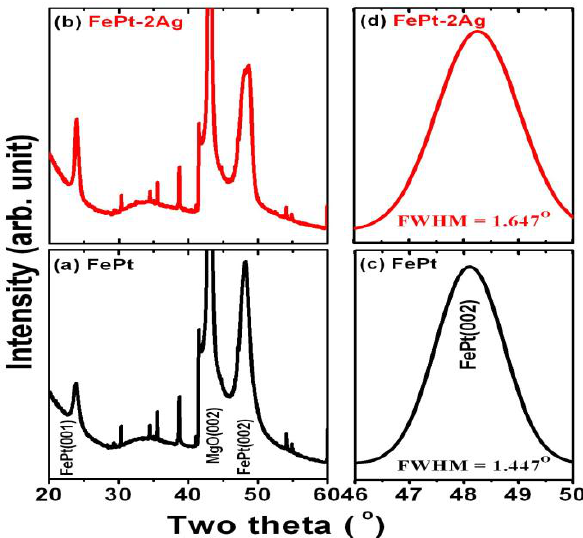
Figure 6. X-ray diffraction scan patterns (XRD) for the [Fe/Pt] 18 multilayer films ( a ) without and ( b ) with two ultrathin Ag (0.5 nm each) nanolayers. The corresponding slow scan curves of the FePt (002) peak in the θ – 2θ scan ( c ) without and ( d ) with insertion of two Ag nanolayers are related with ( a ) and ( b ), respectively.